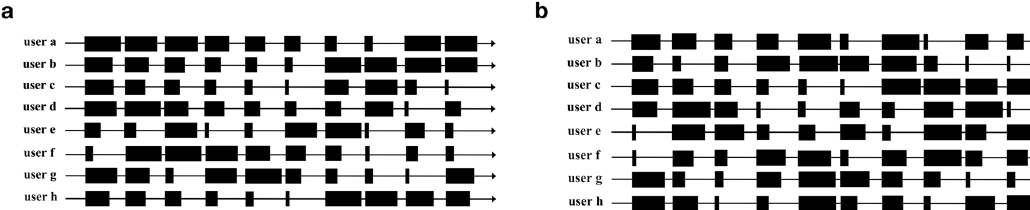
Figure 8. Initial channel distribution settings. ( a ) The distributions of users for each channel during 0–3000 iterations. ( b ) The distributions after 3000 iterations.